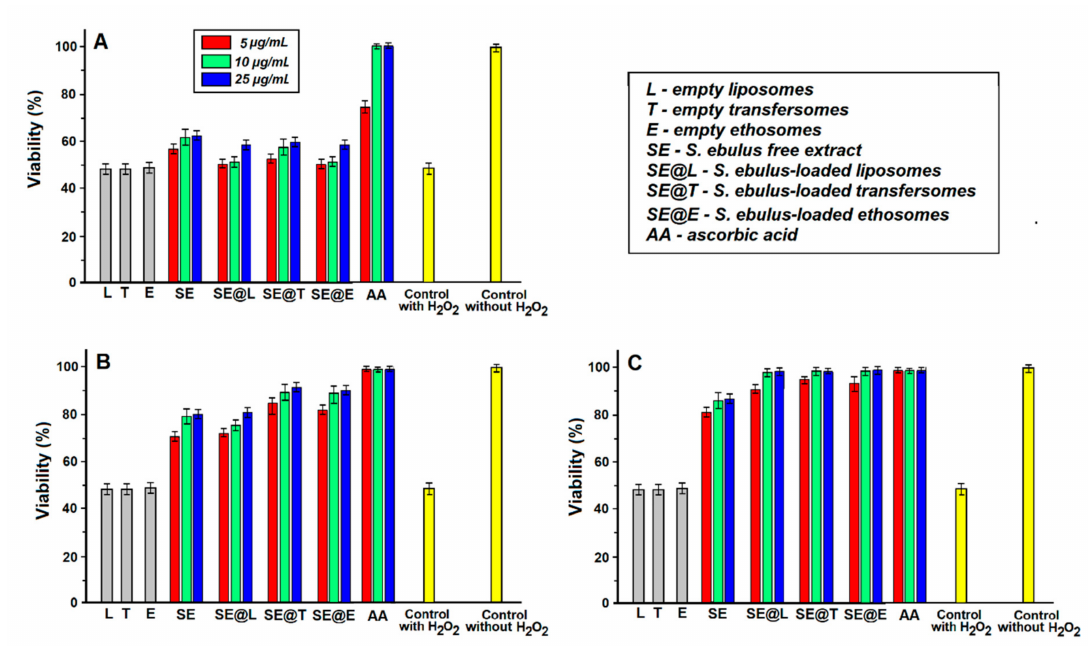
Figure 6. E ff ect of H 2 O 2 on L-929 cell viability after exposure. Viability of L-929 mouse fibroblast cells after 1 h ( A ), 12 h ( B ) and 24 h ( C ) pre-treatment with free and loaded-SE leaves extract before exposure at hydrogen peroxide solution of 50 mM concentration during 4 h are